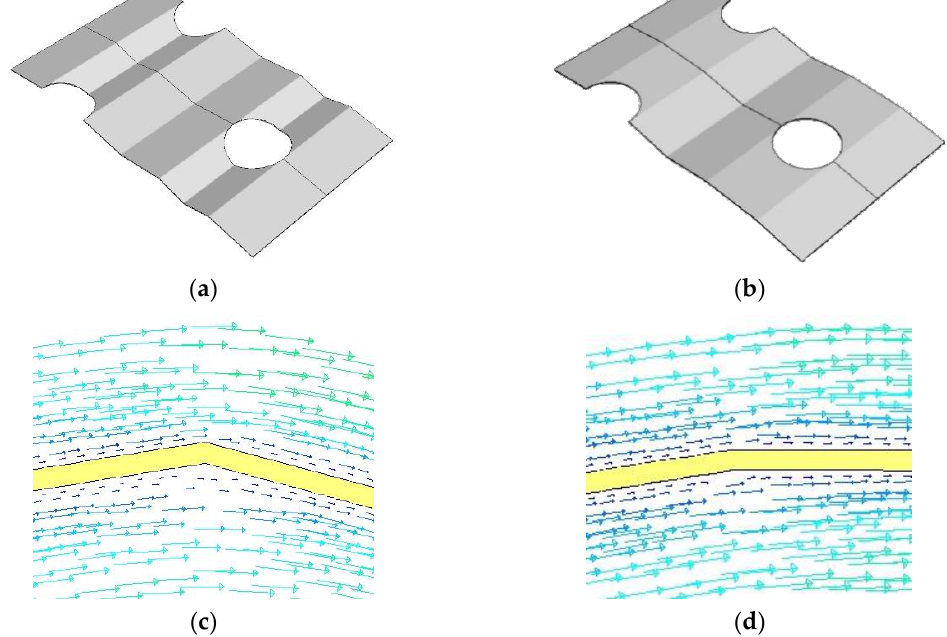
Figure 4. Comparison of the referenced wavy fins and combination of flat and wavy fins: ( a ) Reference wavy fin geometry; ( b ) combination of flat and wavy fins geometry; ( c ) re-circulation zone in wavy fins; ( d ) re-circulation zone in combination of flat and wavy fins.